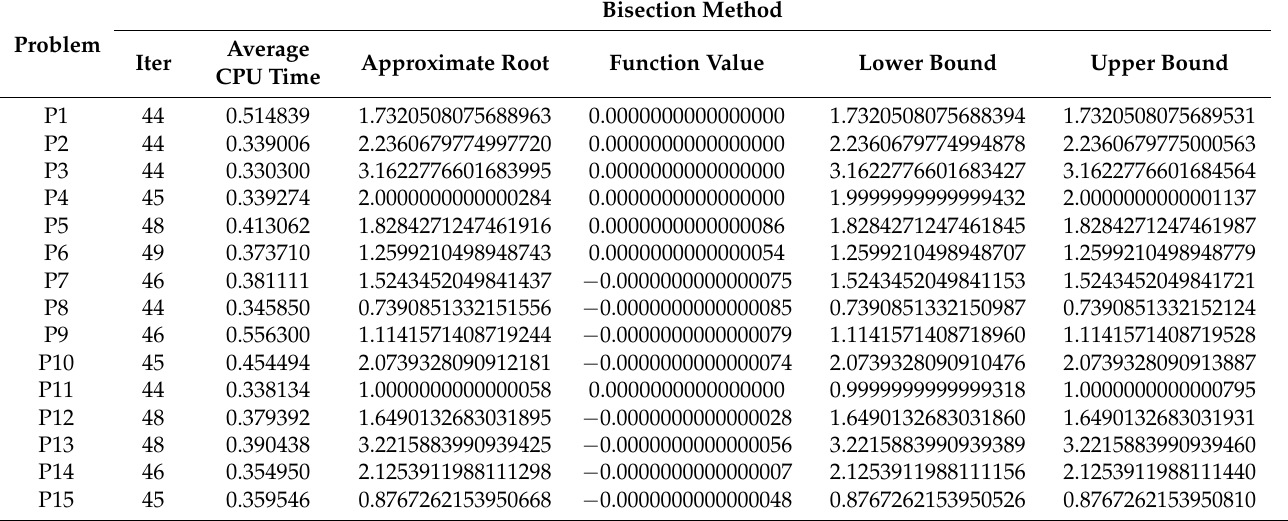
Table 3. Solutions of fifteen problems by the bisection